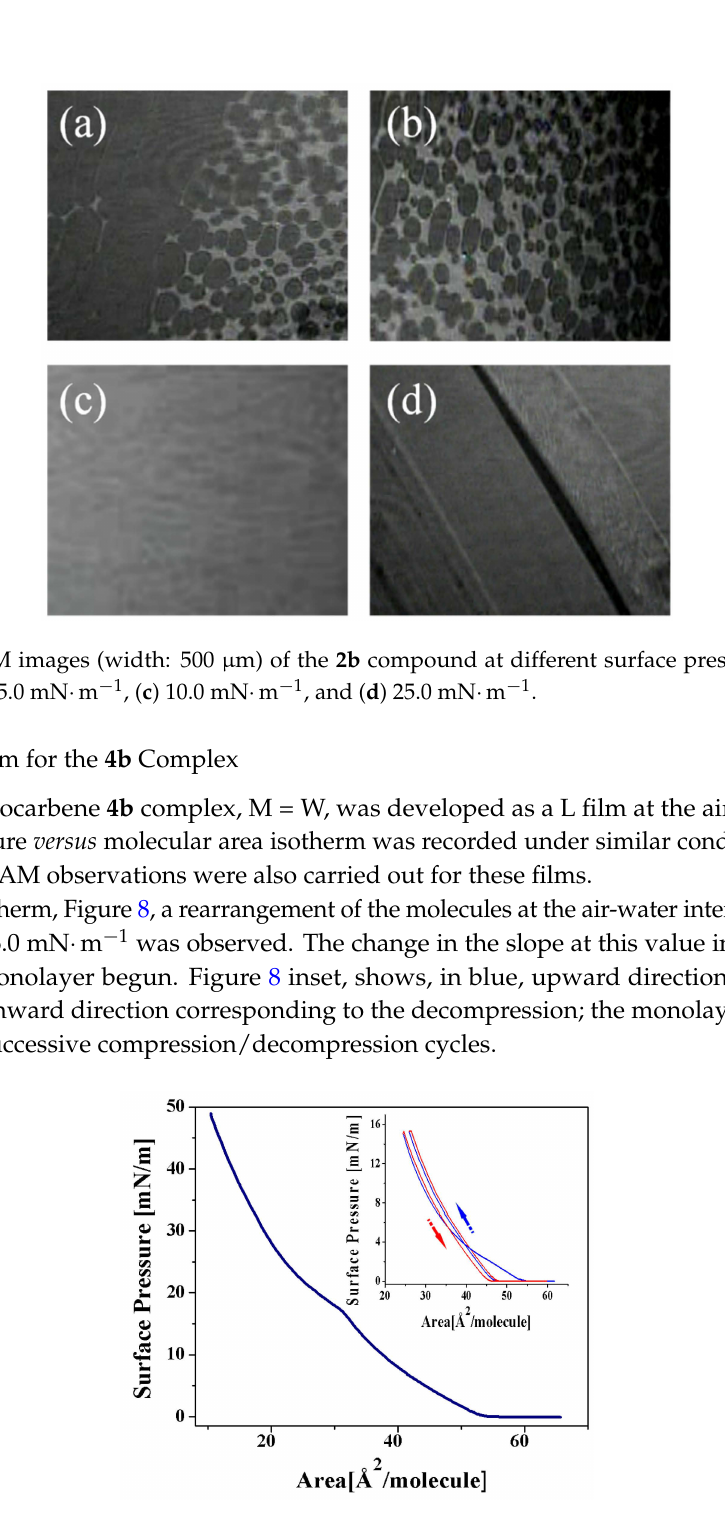
Figure 8. Surface pressure vs. molecular area isotherm of phenyl aminocarbene complex 4b , M = W. Inset shows the reversibility of two successive compression-expansion